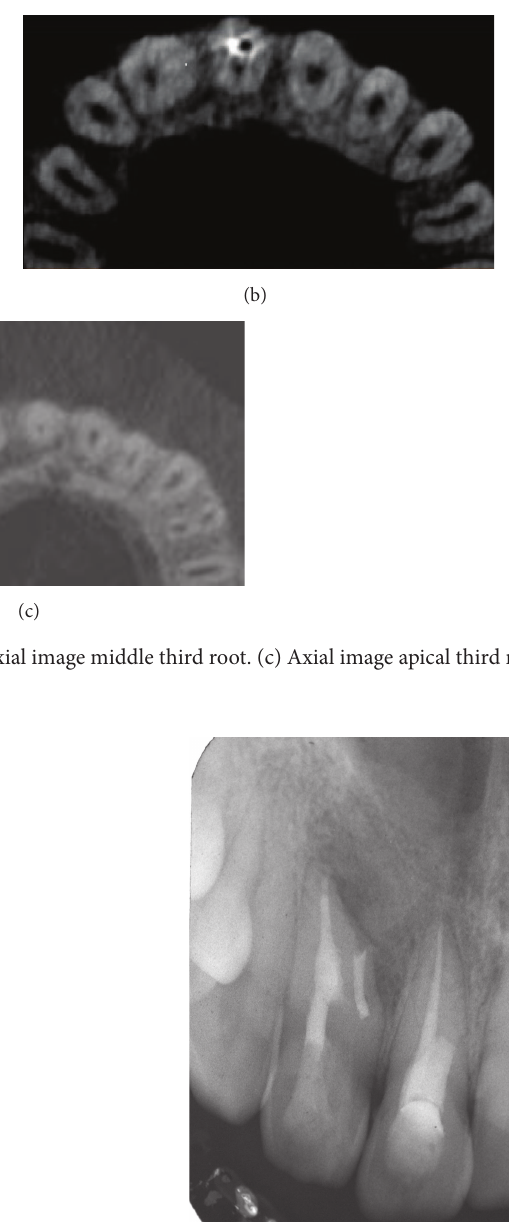
Figure 5: Sagittal view.